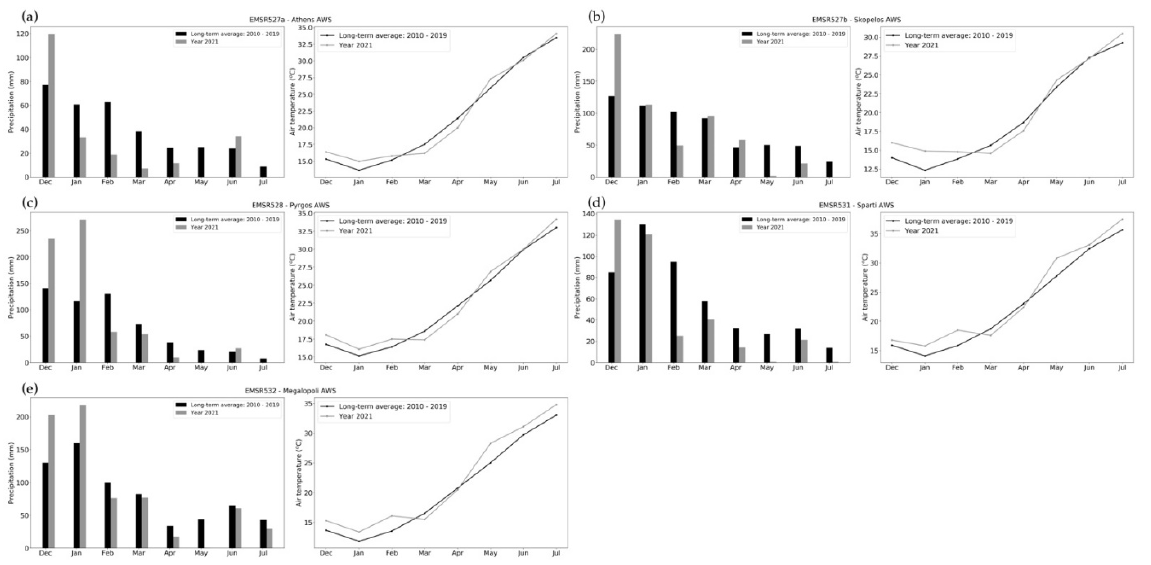
Figure 3. Mean monthly values of precipitation (bars) and daily maximum air temperature (lines) for the period December–July: ( a ) Athens AWS-EMSR527a, ( b ) Skopelos AWS-EMSR527b, ( c ) Pyrgos AWS-EMSR528, ( d ) Sparti AWS-EMSR531, and ( e ) Megalopoli AWS-EMSR532. Black bars (lines) denote the climatological means computed based on the record span of each AWS (Table 2). Grey bars (lines) denote the 2020/2021 recorded values.